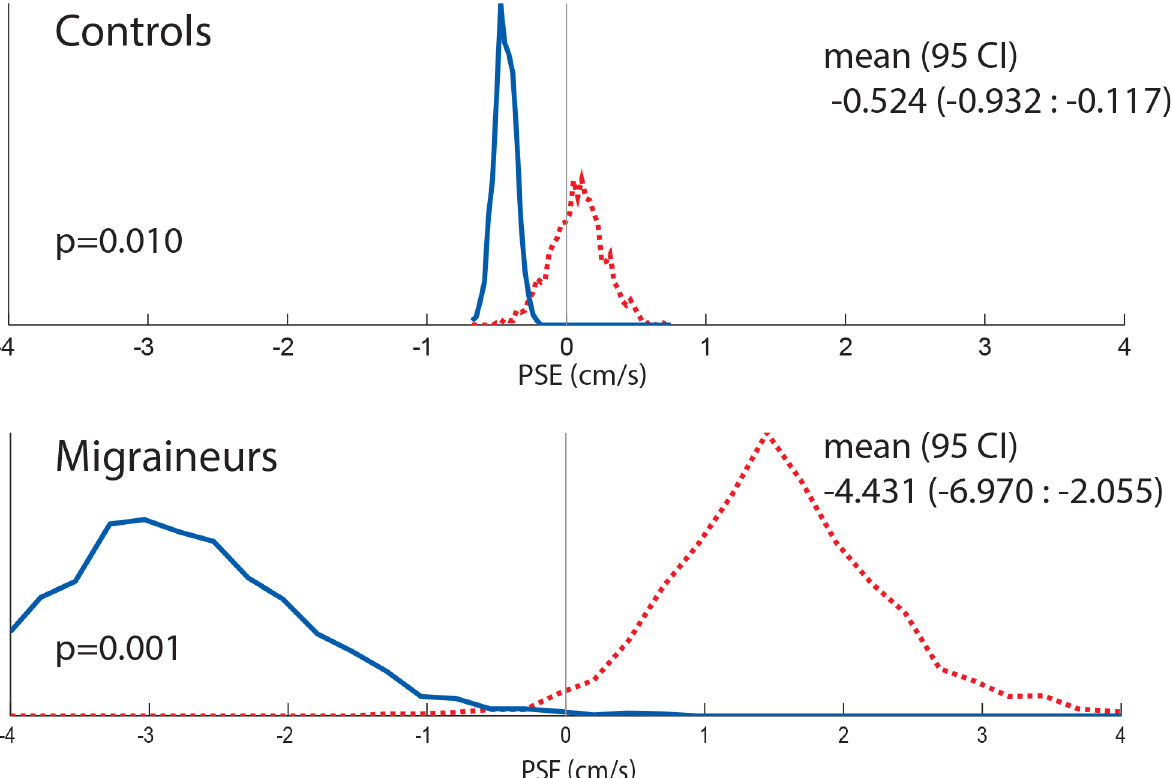
Fig 7. Histogram comparing combined controls and migrainers response using random resampling of responses for 8s visual stimuli. Responses from all subjects were included. Responses collected with looming VFM are represented with a dashed red line, receding VFM responses are represented with a solid blue